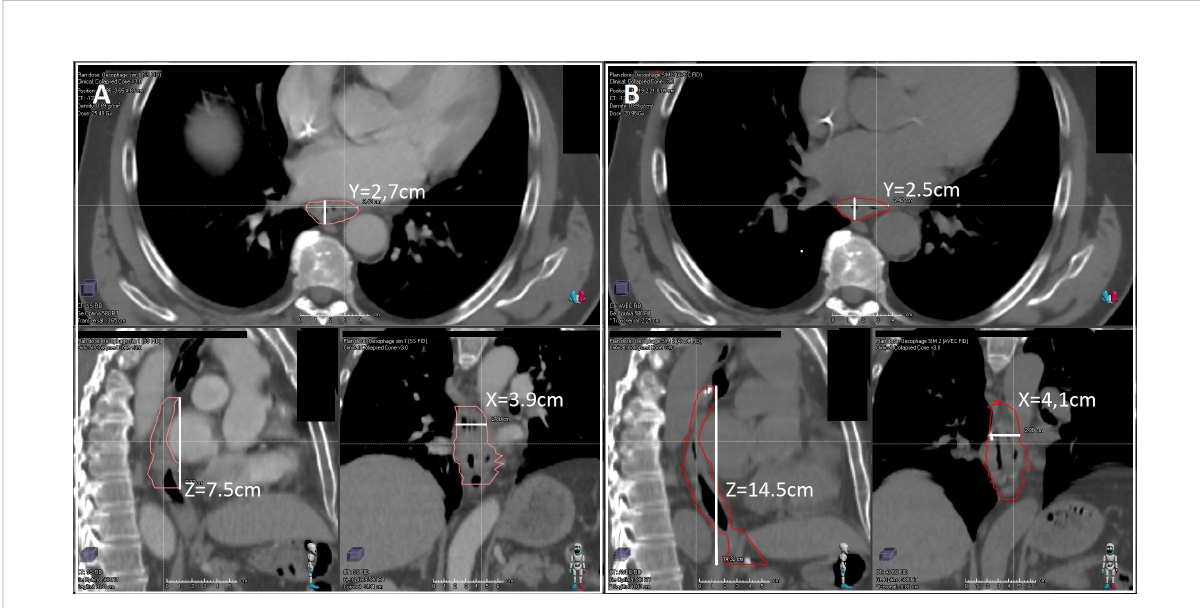
FIGURE 2 Example of measurement of GTV, CTV, and PTV in X (right - left dimension) or Y (anterior - posterior dimension), or Z (cranio-caudal dimension). for patient n°10 on CT1 (A) and B on CT2 (B) .